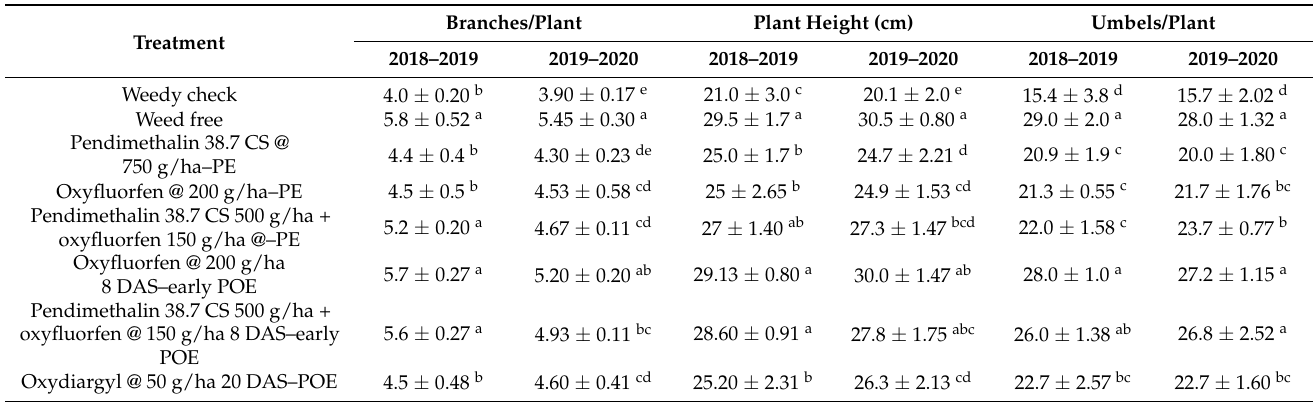
Table 1. Effect of herbicidal weed management on plant growth and umbels of